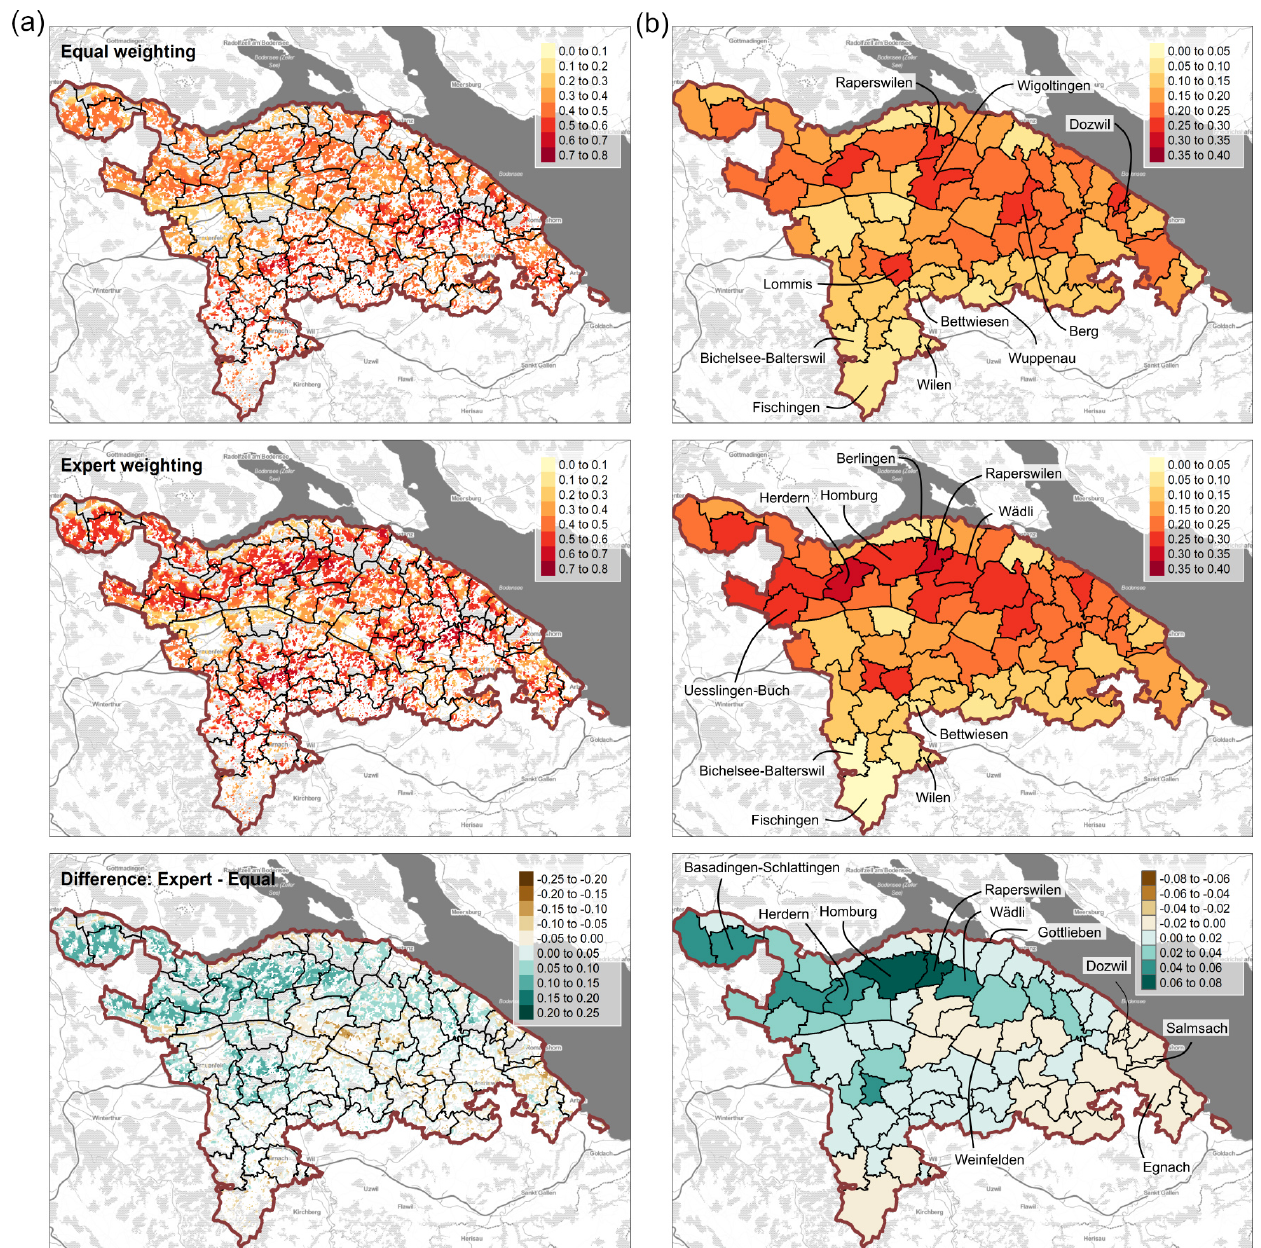
Figure 5. The mapped results of equal weighting, expert weighting methods, and their difference across Podravska. On the left (a) , masked with agricultural used land and before aggregation on LAU2 regions (black borders). On the right (b) , after aggregation for each LAU2 region. LAU2 regions are labelled when showing relatively high or low vulnerability, or relevant differences between the weighting